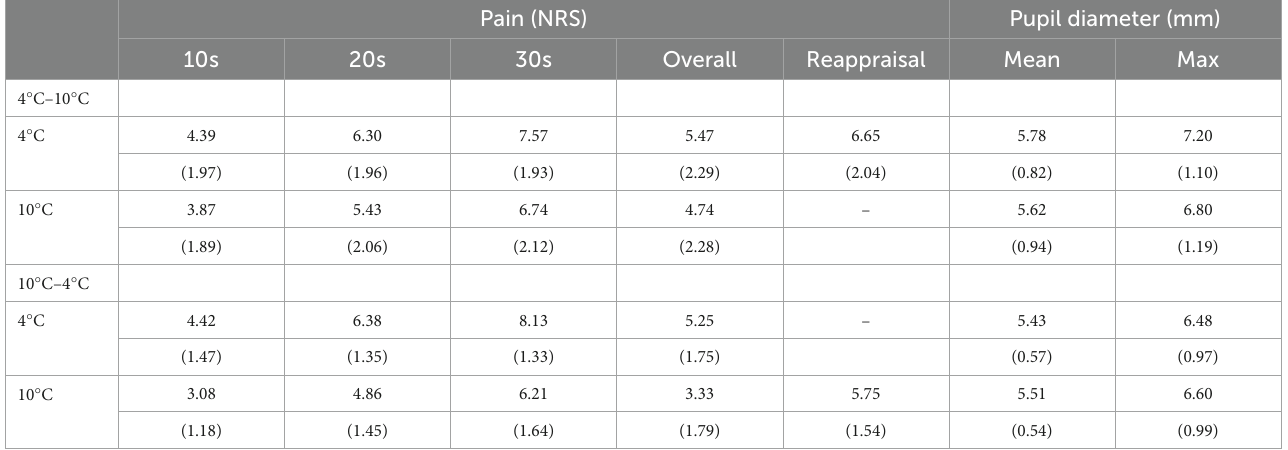
TABLE 2 Means and Standard deviations for pain intensity and pupil